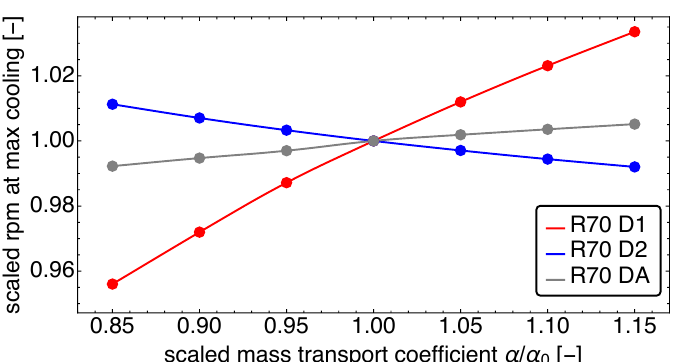
Figure 9. The rescaled maximum cooling power is shown as function of the rescaled mass transport coefficient for the three engine designs D1, D2, and DA, and r = 0.7 regeneration extent. The rescaling is with respect to the properties of the maximum cooling power operating point for the base case.